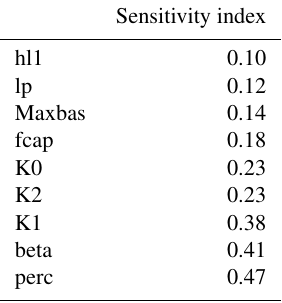
Table 3. Variance-based sensitivity analysis results for HBV pa- rameters: first-order sensitivity index representing the contribution of varying a single parameter to the variance of the model output. Lower values indicate lower